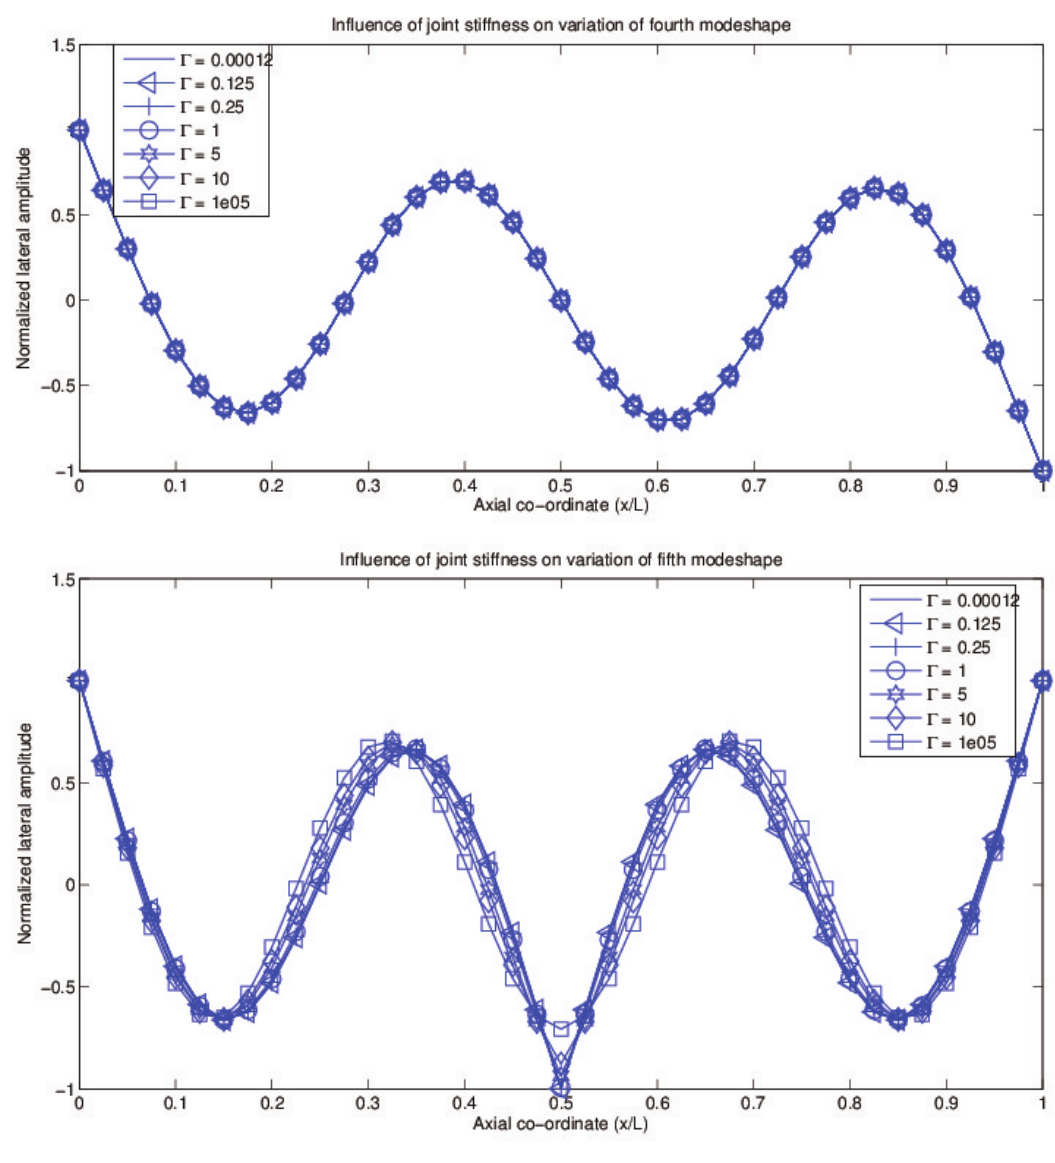
Fig. 5. Influence of joint stiffness on variation of modeshapes (Mode4 and Mode5) of free-free beams (Joint located at ξ 2 ).